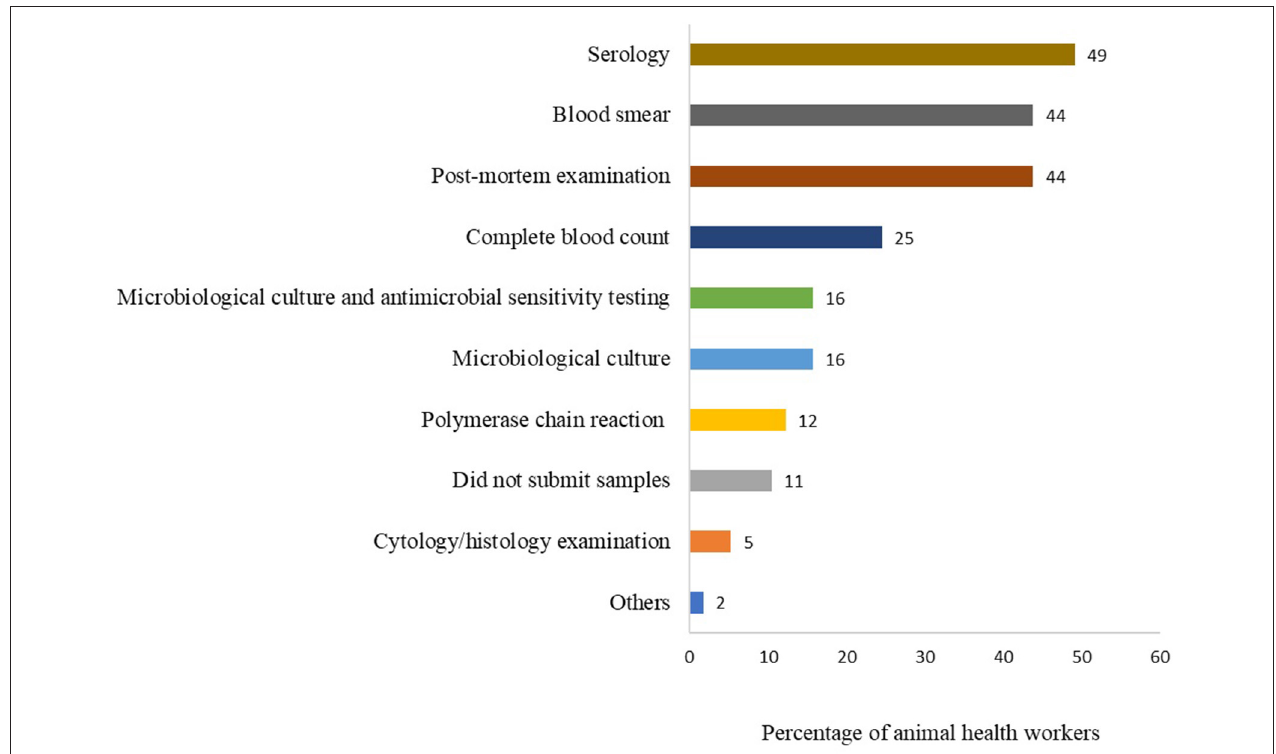
FIGURE 5 | Type of tests commonly requested by animal health workers when submitting samples to laboratories for clinical diagnosis. This question had multiple responses. Bars represent percent of animal health workers ( n = 57) that requested each type of test.